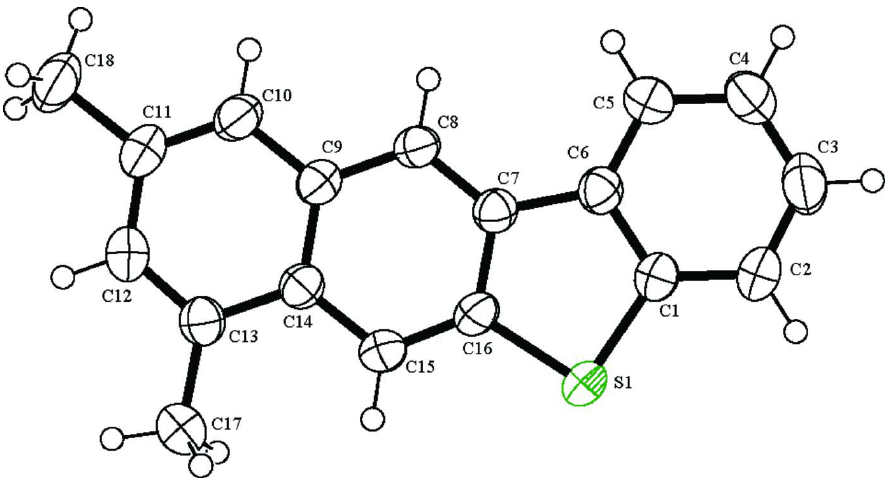
Figure 1 The molecular structure of (I), with atom labels and 50% probability displacement ellipsoids for non-H atoms. 1,3-Dimethylbenzo[ b